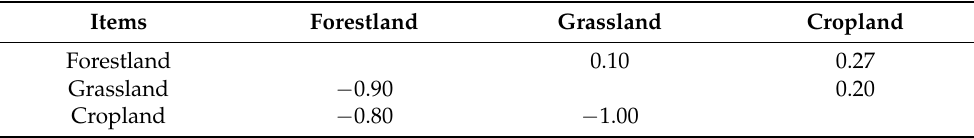
Table 2. SOC impact factors for change in land use conversion. Items Forestland Grassland Cropland Forestland 0.10 0.27 Grassland − 0.90 0.20 Cropland − 0.80 −